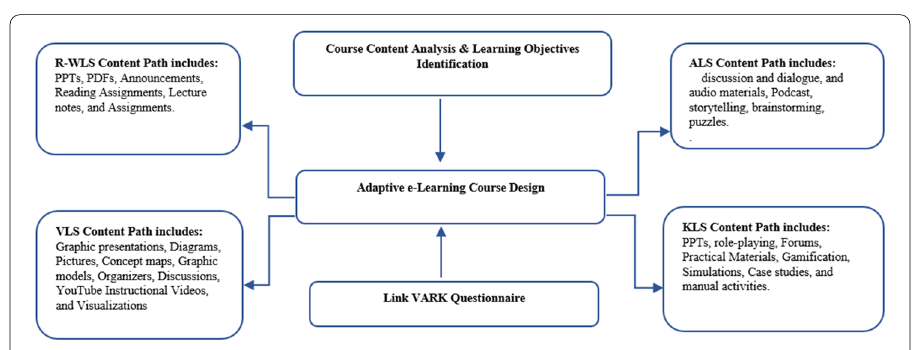
Fig. 4 Adaptive e‑course